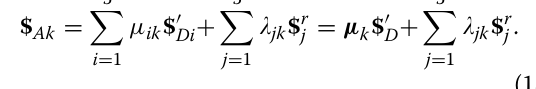
Fig. 2 Typical 3-RPS parallel mechanism